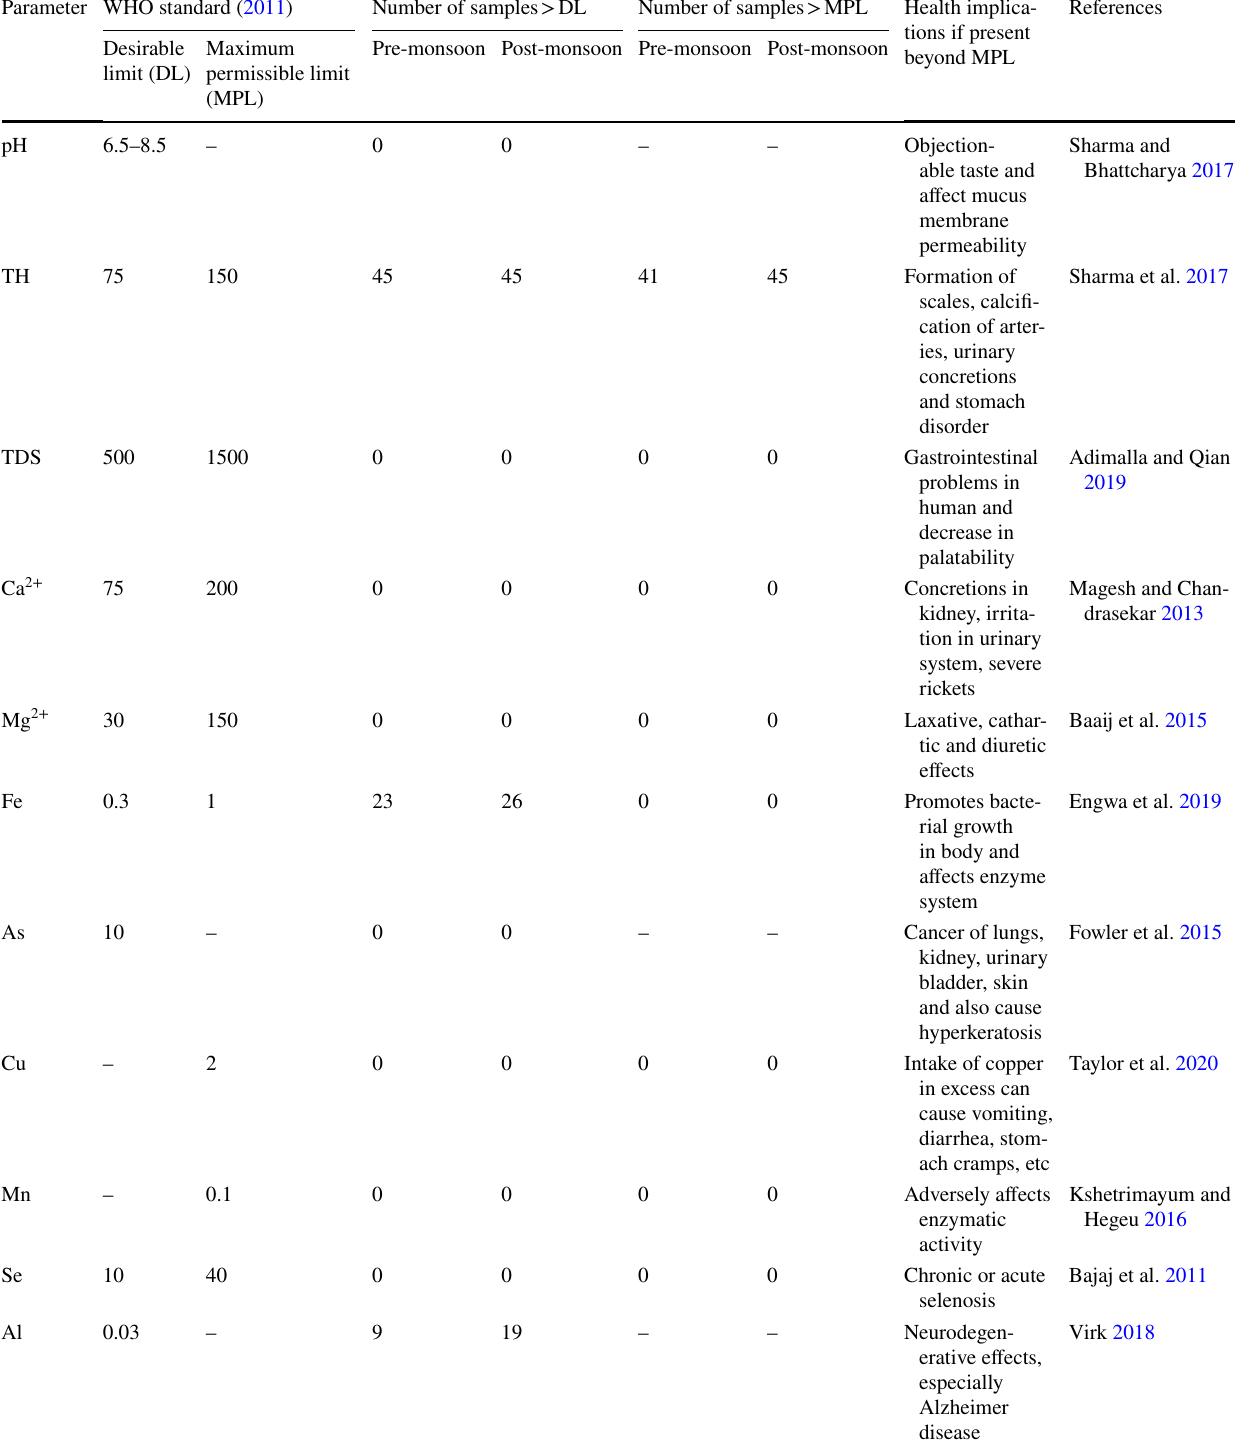
Table 5 Guideline values (WHO 2011) for drinking water along with number of samples exceeding maximum permissible limit (MPL) and desirable limit (DL) and health